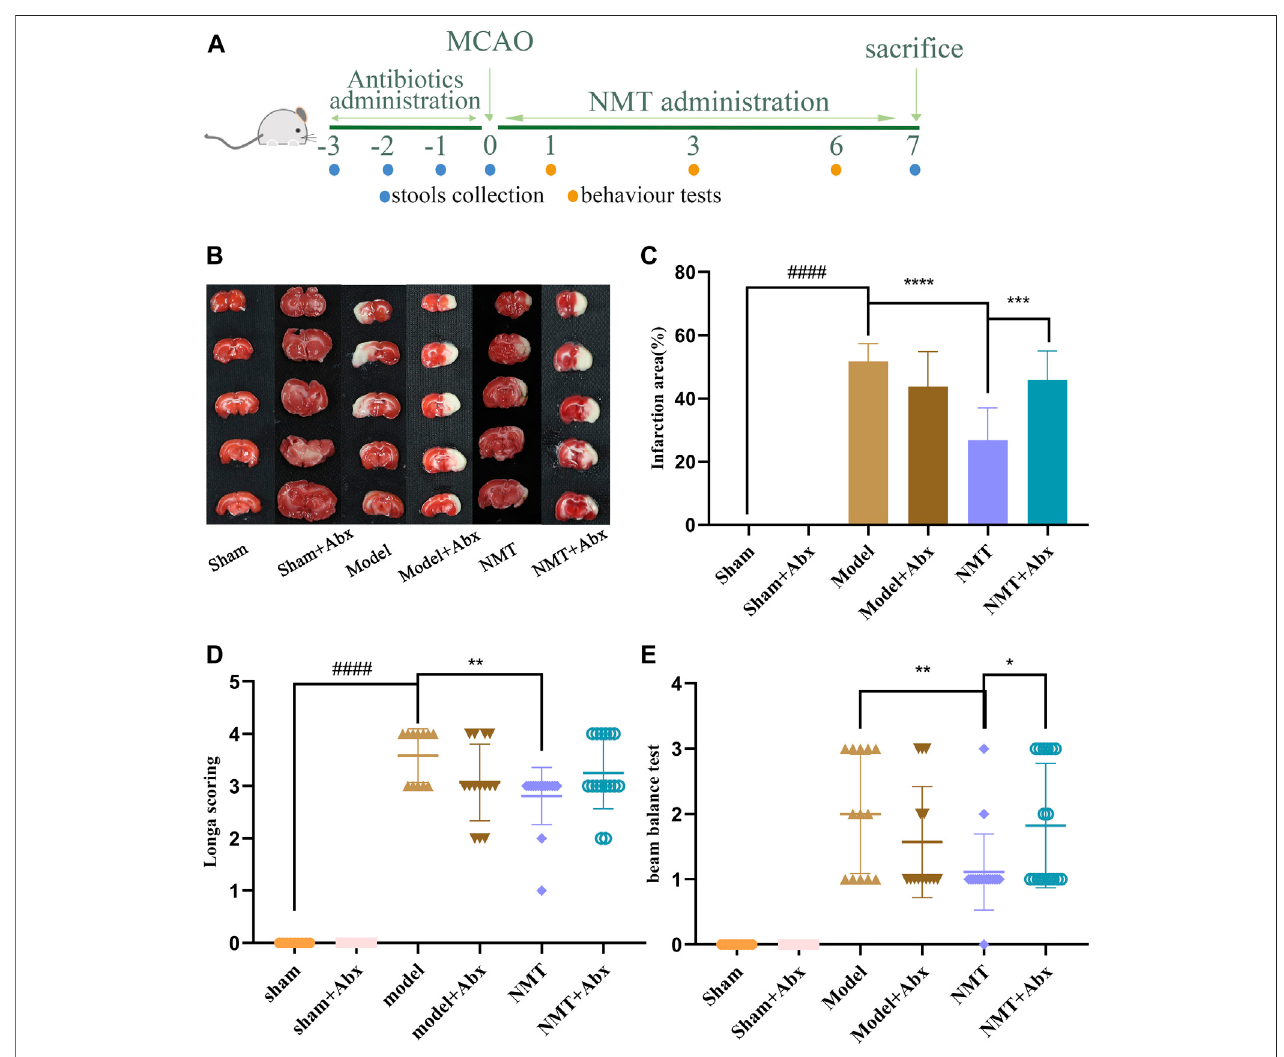
FIGURE 7 | NMT depended on intestinal fl ora to improve stroke prognosis. (A) The procedures of animal experiments in PGF rats. (B) TTC staining. (C) Cerebral infarct area percentage ( n (cid:1) 6). Compared with sham group, statistical signi fi cance was considered at ## p < 0.01, ### p < 0.001 for all the test; Compared with model group, statisticalsigni fi cance wasconsidered at * p < 0.05, ** p < 0.01and *** p < 0.001for allthetests. (D) Neurologicalscore( n (cid:1) 9). (E) Beambalance test( n (cid:1) 9). Error bars represent Mean ± SD.